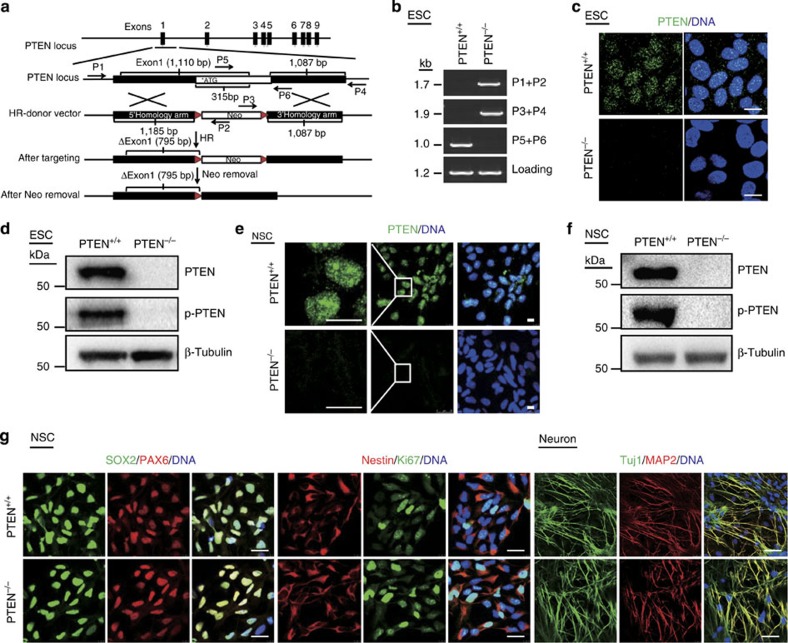
Generation and characterization of PTEN-deficient NSCs.(a) Schematic representation of TALEN-based PTEN targeting strategy. Primers used for b are shown as arrows (P1–P6). The donor vector includes a neomycin-resistance cassette (Neo) allowing for positive selection. (b) PCR analysis of WT and PTEN−/− ESCs using primer pairs indicated (P1+P2: 1,744 bp; P3+P4: 1,872 bp; P5+P6: 1,035 bp). (c) Immunofluorescence analysis performed on WT and PTEN−/− ESCs with an anti-PTEN antibody. PTEN was absent in the PTEN−/− ESCs. Nuclei were stained with Hoechst 33342. Scale bars, 12.5 μm. (d) Immunoblotting verified the absence of PTEN protein in PTEN−/− ESCs with anti-PTEN and anti-phospho-PTEN (Ser380) antibodies. β-Tubulin was used as loading control. (e) Immunostaining of PTEN in WT and PTEN−/− NSCs with an anti-PTEN antibody. Scale bars, 10 μm. (f) Immunoblotting analysis of PTEN and phospho-PTEN in WT and PTEN−/− NSCs. (g) Immunostaining of neural progenitor- (left) and neuron- (right) specific markers in WT and PTEN−/− NSCs (left) and their neuronal derivatives (right). Scale bars, 25 μm (NSC) and 50 μm (neuron).